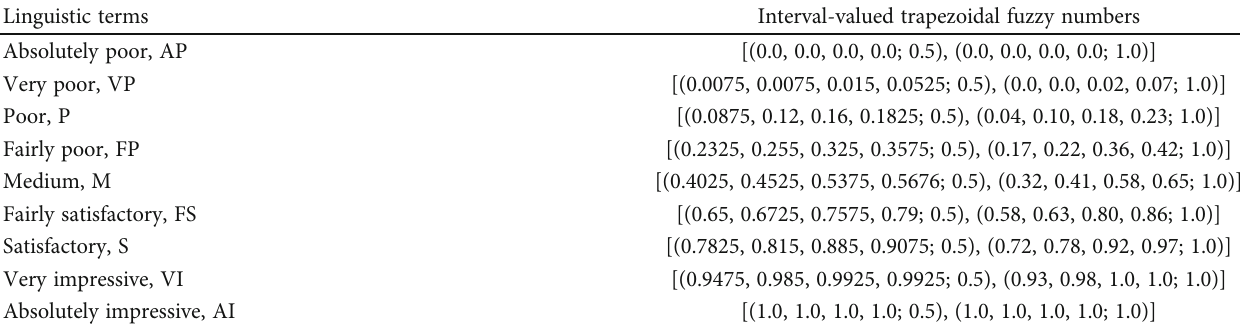
Table 2: Nine-member linguistic terms (rating scale) and their corresponding interval-valued fuzzy numbers. Linguistic terms Interval-valued trapezoidal fuzzy